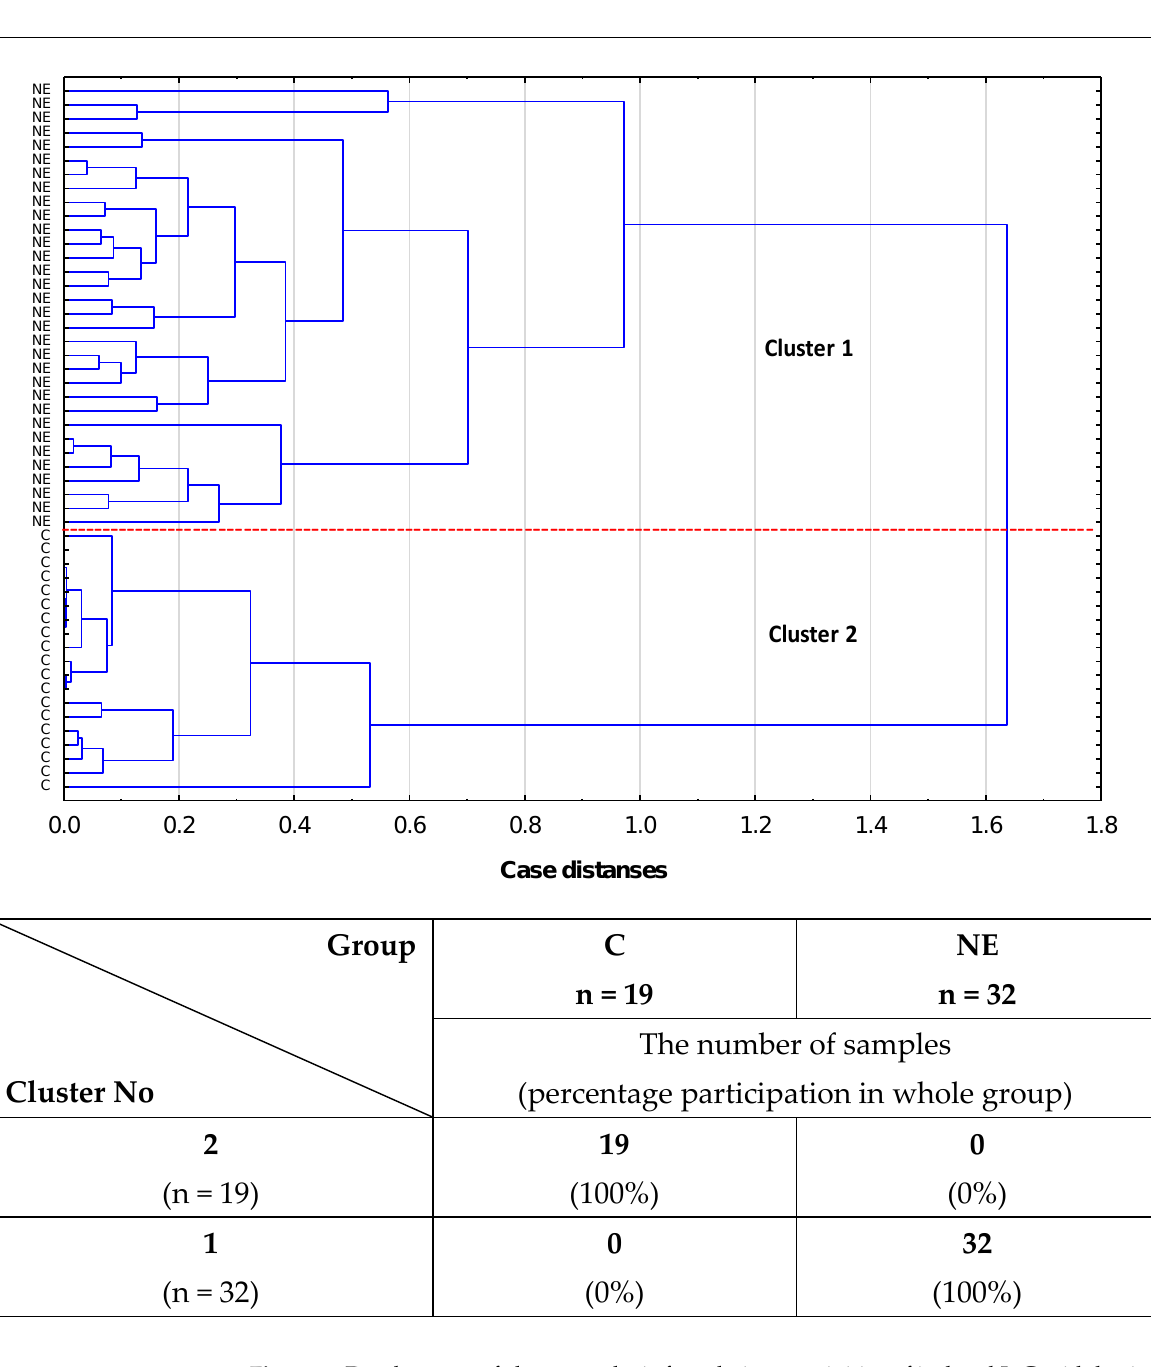
Figure 6. Dendrogram of cluster analysis for relative reactivities of isolated IgG with lectins in non-endometriosis women and healthy subjects. Cluster analysis was done only for parameters for which the AUC value was high (>0.9) in ROC curve analysis, and which significantly differentiated non-endometriosis patients from healthy women. Each sample is represented by a vector of four features: MPL, VVL, Jacalin, and PHA-L relative reactivities with i-IgG glycans. NE—non-endometriosis patients, C—control group of healthy women. MPL— Maclura pomifera lectin, VVL— Vicia villosa lectin, Jacalin — Artocarpus integrifolia lectin, and PHA-L — Phaseolus vulgaris leucoagglutinin.